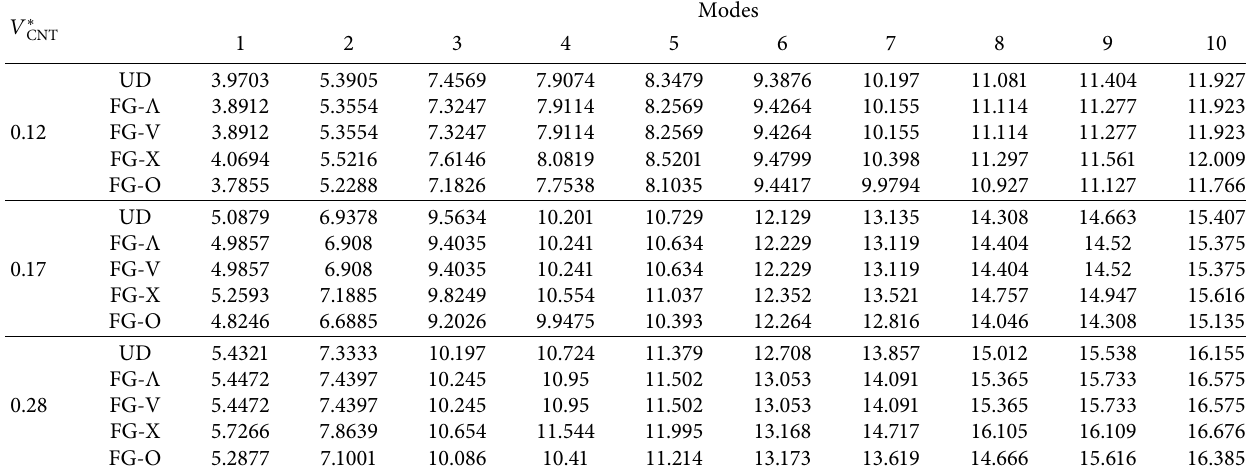
Table 7: The dimensionless frequencies of non-stepped FG-CNTRC plate.